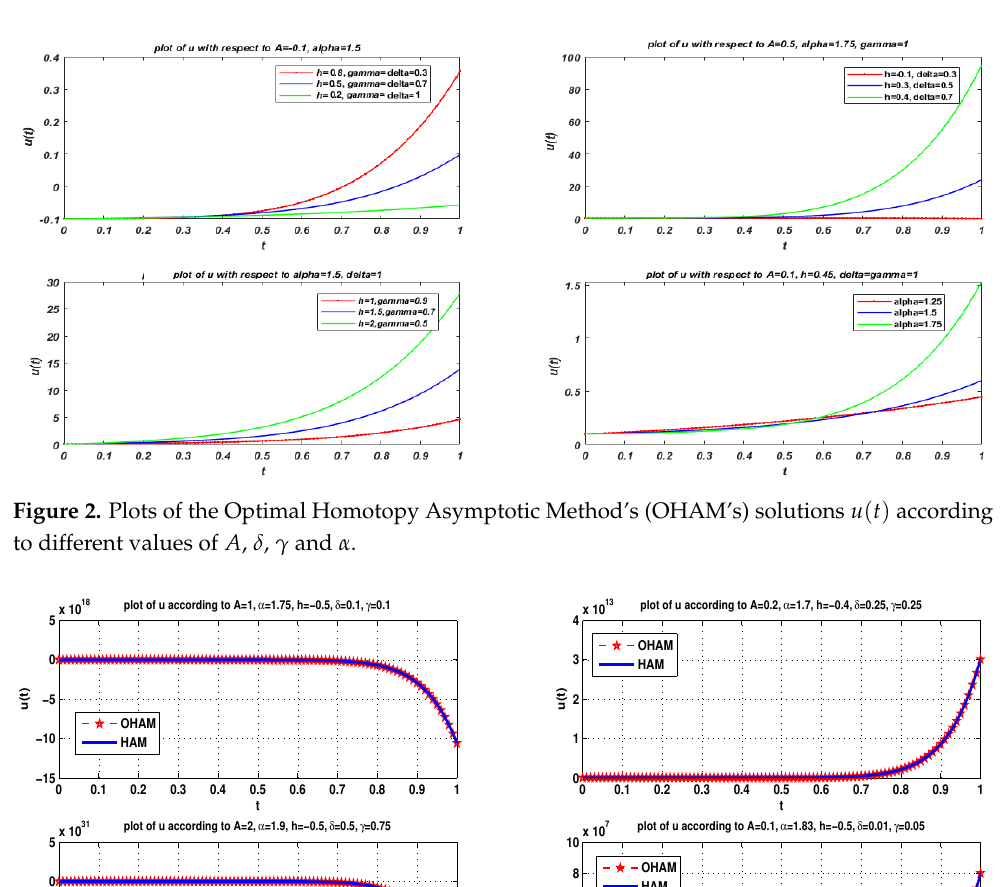
Figure 1. Plots of several h –curves according different values: ( a ) A = 0.75, γ = δ = 1, ( b ) A = 1.25, γ = 0.3, δ = 0.5, ( c ) A = 2, γ = δ = 1, ( d ) A = 1.5, γ = δ = 1.